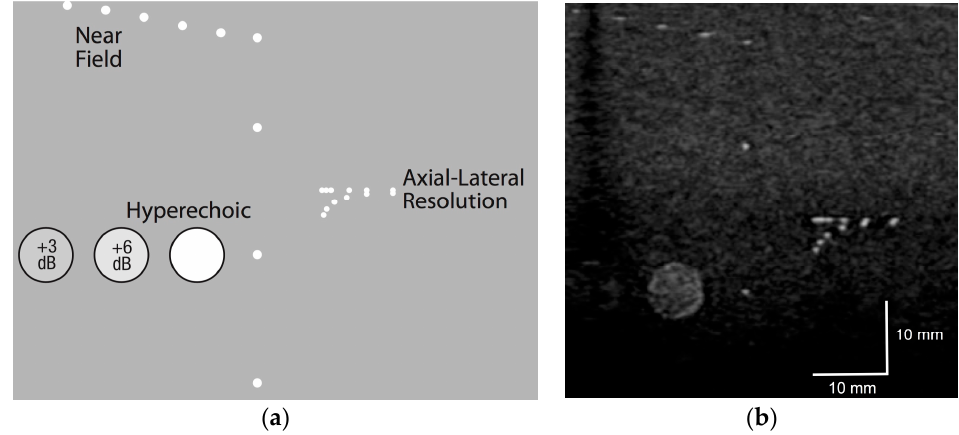
Figure 3. The CIRS 054GS ultrasound phantom: ( a ) template showing the various targets; and ( b ) data captured by the ultrasound transducer prior to the start of the clinical trial.